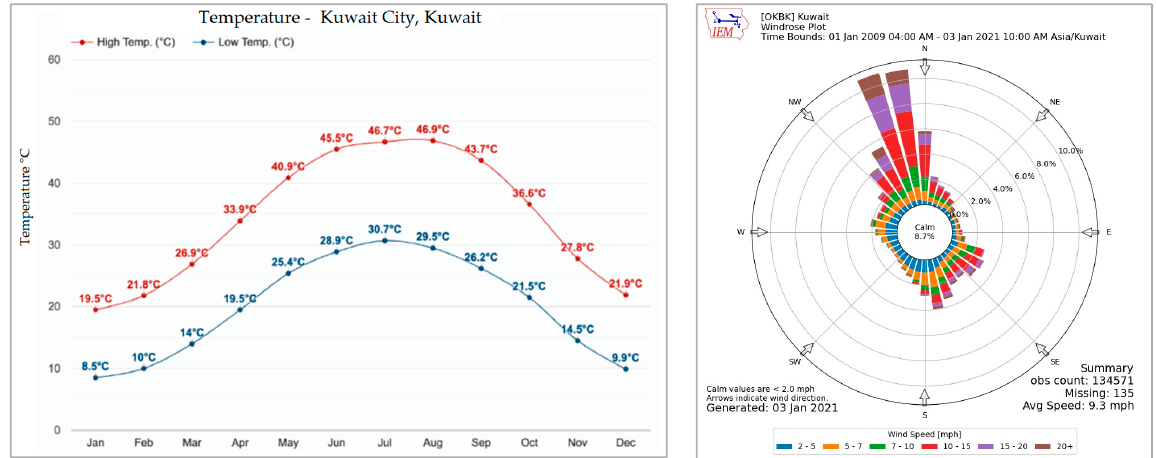
Figure 2. Left : Climatic average outdoor monthly maximum and minimum temperature for Kuwait City, Kuwait; Right : The annual Windrose diagram for Kuwait showing the consistency in wind direction [47].